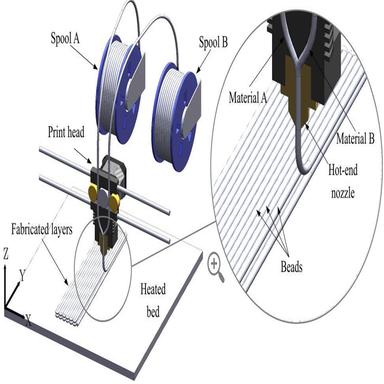
Multi-material fused filament fabrication process.